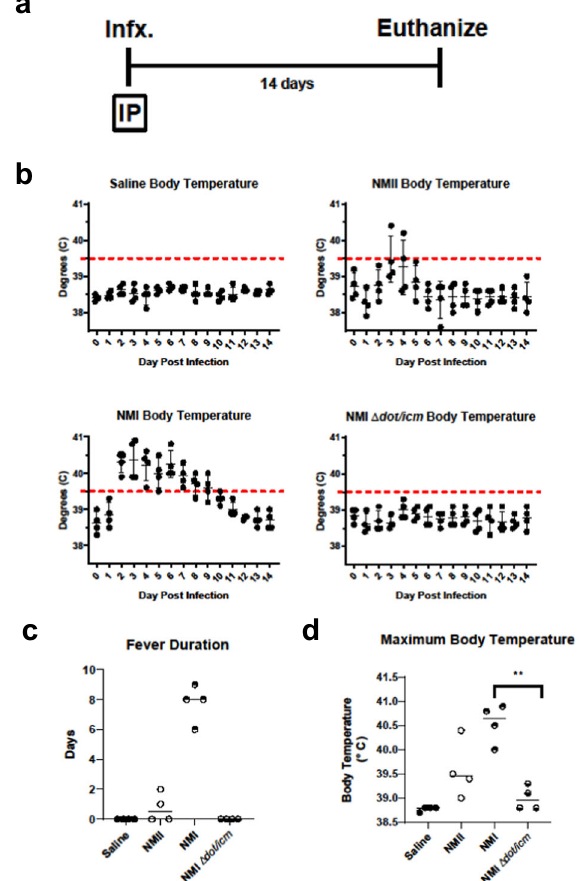
Fig. 3 Infection by NMI Δ dot/icm does not cause fever in guinea pigs. a Body temperatures were recorded daily from the day of infection (day 0) until the day of euthanasia (day 14). b Temperatures were plotted for each individual animal per time point throughout the duration of infection. Fever was de fi ned as ≥ 39.5 °C and is indicated by the dotted line. Fever duration c and maximum body temperature at any given point post-infection d are presented for each animal. These two endpoints were evaluated based on differences in group means (horizontal bar) with associated con fi dence intervals. Error bars represent standard deviation. For each reported comparison, p -values were computed at the α = 0.05 level for two-sided two-sample t tests, allowing for unequal variances between groups. No adjustment was made for multiple comparisons due to the sample sizes ( n = 4) and the descriptive nature of the study. ** p ≤